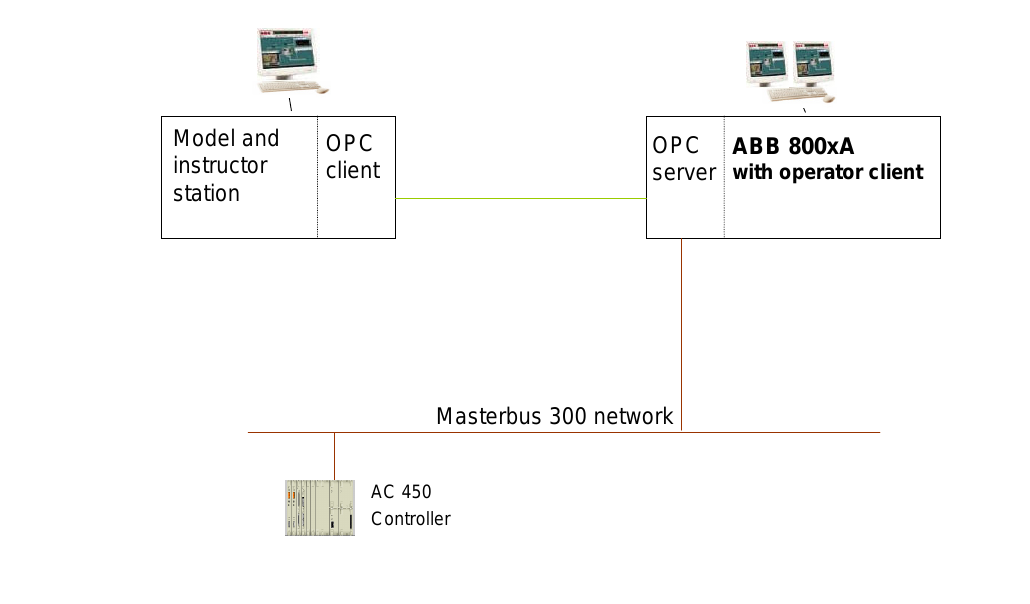
Figure 5: Roasting and sulphuric acid plant simulator